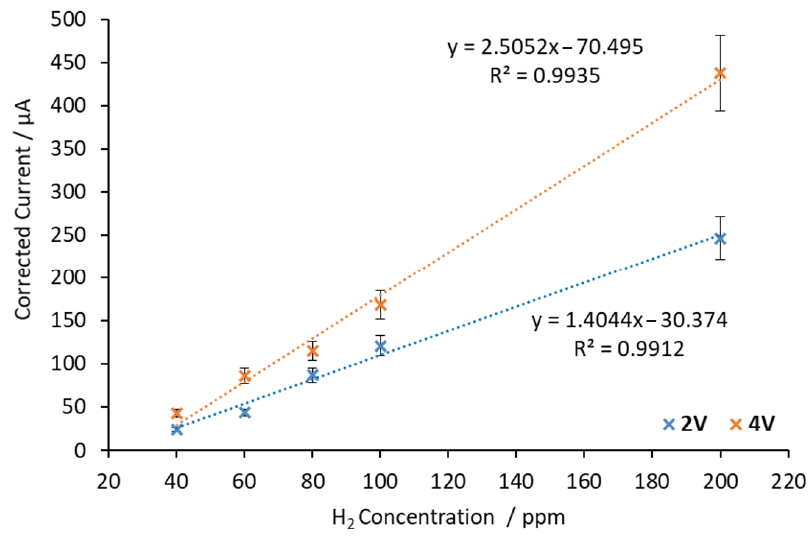
Figure 10. Calibration curves obtained with BaCeZrY by applying 2 V and 4 V between electrodes at 600 °C.